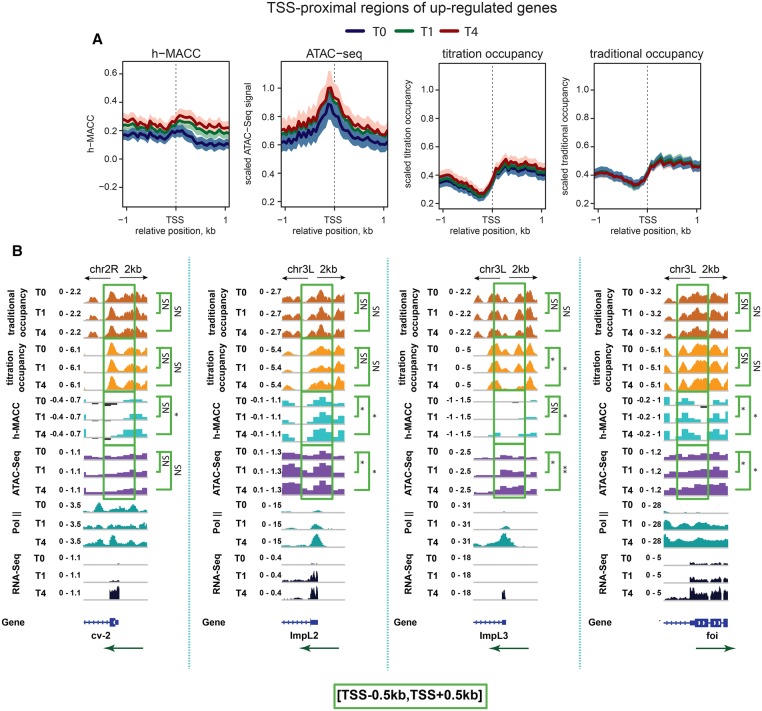
Chromatin organization at promoter regions of the genes up-regulated during the UPR. (A) Average profiles of chromatin accessibility and nucleosome occupancy characteristics around the TSSs of up-regulated genes. From left to right, results are shown for h-MACC, ATAC-seq, titration occupancy, and “traditional” occupancy. The thick lines correspond to the average profiles, while colored areas give reference of the standard errors of mean (SEM). (Blue) The 0-h time point; (green) the 1-h time point; (red) the 4-h time point. (B) Examples illustrating chromatin structure at individual promoters of up-regulated genes. Profiles of nucleosome occupancy, h-MACC, ATAC-seq, H3K27ac, Pol II, and RNA-seq are shown in each plot. The metrics are identified at the left of each plot, and the directions of transcription are marked with green arrows. The significance of the difference between T0 and T1/T4 profiles around the TSS (±500 bp) is indicated at the right (one-sided signed rank test) (see the legend for Fig. 2 for details).